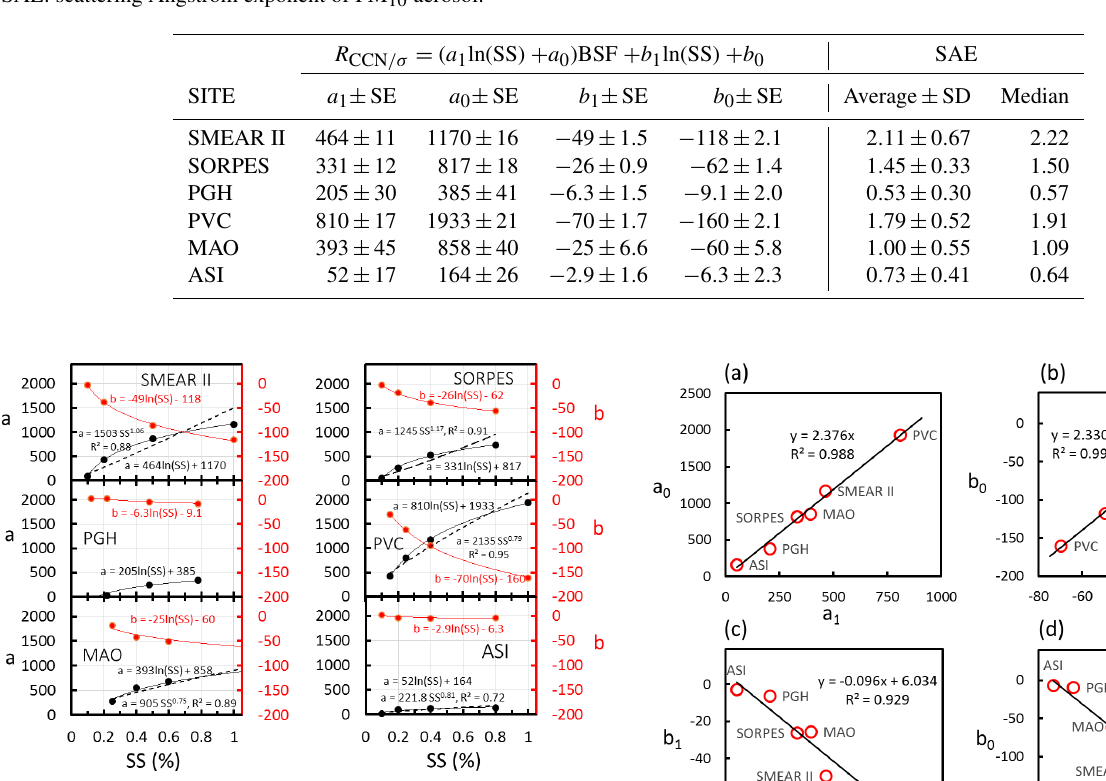
Figure 5. The slopes and offsets, a and b , of the linear regres- sions R CCN /σ = a BSF + b of each station (Table 3) as a function of supersaturation (SS). Two types of functions, a logarithmic and a power function, were fitted to the coefficient a , and to coefficient b only a logarithmic function was fit. The squared correlation coef- ficients R 2 are shown only for the power function fittings; for the logarithmic fittings they were all > 0 . 99.